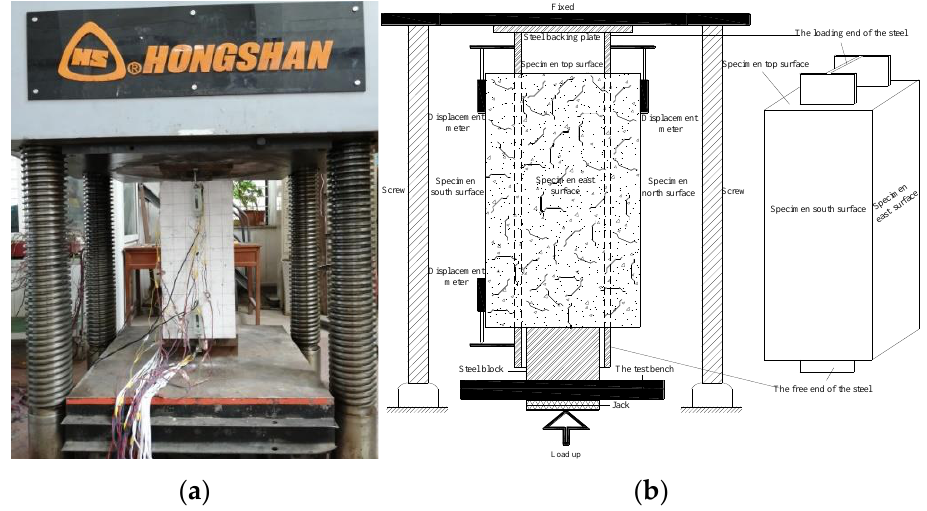
Figure 4. Loading device. ( a ) Laboratory loading . ( b ) Load schematic .